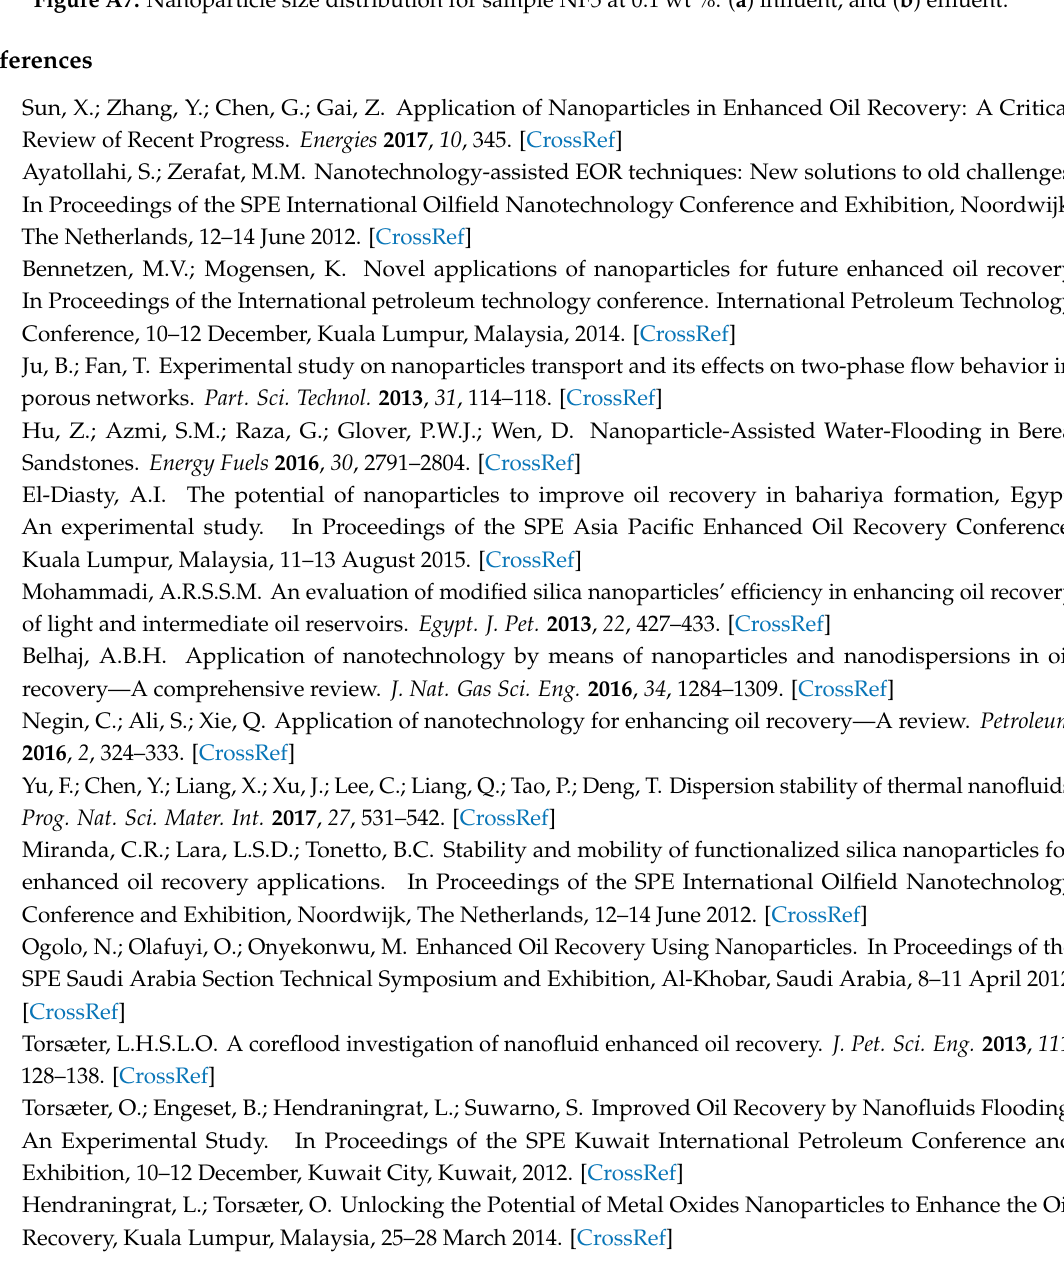
Figure A7. Nanoparticle size distribution for sample NF5 at 0.1 wt %: ( a ) influent; and ( b )